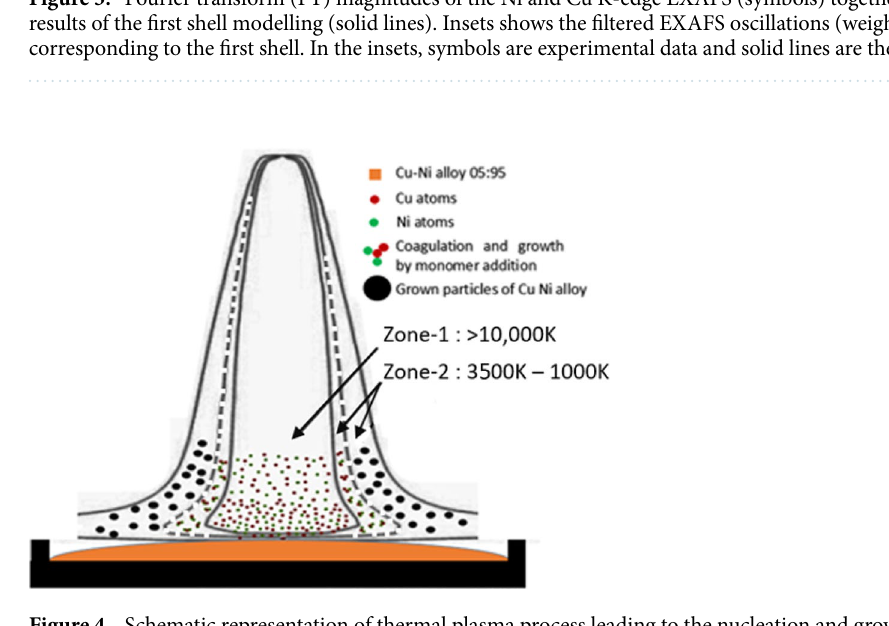
Figure 4. Schematic representation of thermal plasma process leading to the nucleation and growth of nanoparticles by vapour phase condensation. (See also the schematic diagram of the arc-plasma set up shown in Fig .